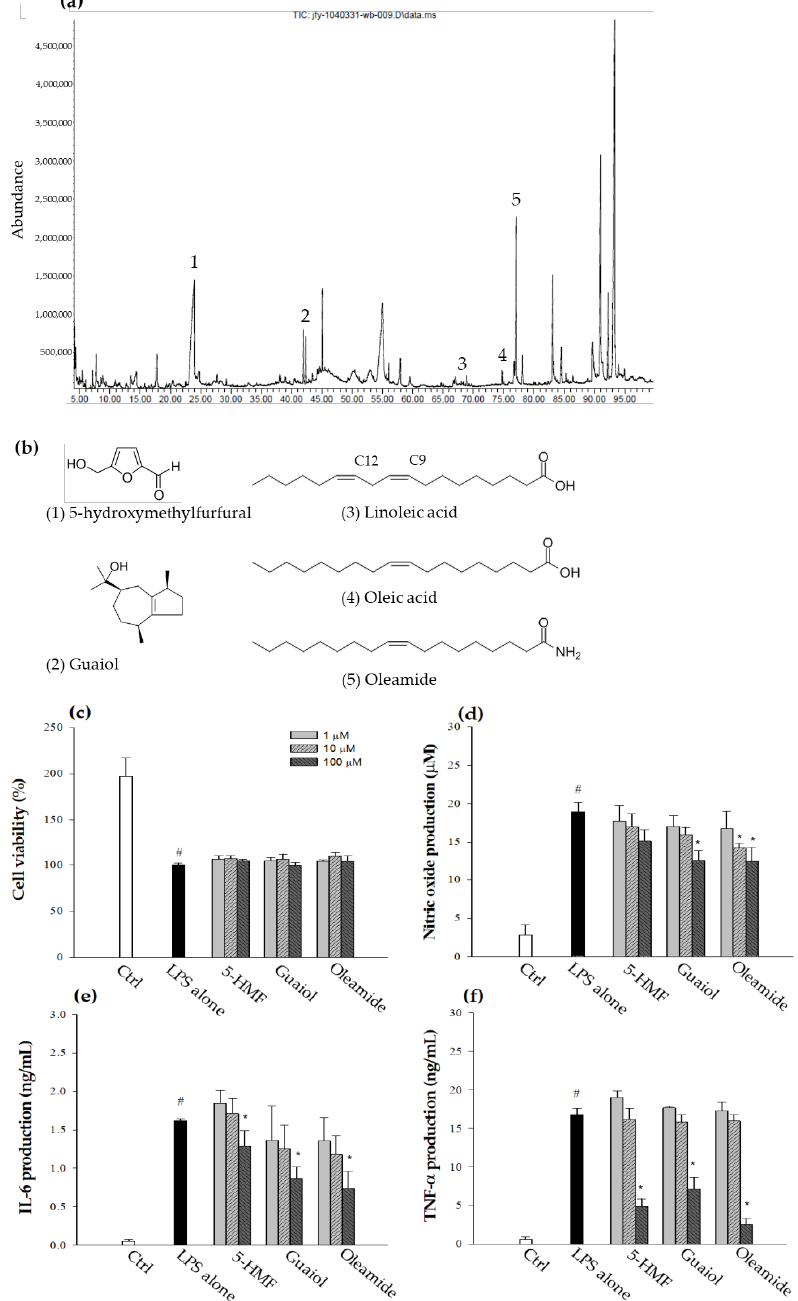
Figure 4. ( a ) GC–MS spectrometry profile of BP-95E-H 2 O-BuOH subfractions of BP. ( b ) Five non- polyphenol components in BP-95E-H 2 O-BuOH subfractions were identified by comparison of their mass spectra with the NIST MS 14.0 database (Gaithersburg) as follows: (1) 5-hydroxymethyl furfural (5-HMF, retention time (RT) = 23.9 min), (2) guaiol (RT = 42.0 min), (3) oleic acid (RT = 67.1 min), (4) linoleic acid (RT = 76.7 min), and (5) oleamide (RT = 77.1 min). ( c ) RAW264.7 cells were treated with 5-HMF, guaiol, and oleamideat for 48 h, and the cell viability was measured with MTT assay. The levels of ( d ) NO, ( e ) IL-6, and ( f ) TNF- α were determined in culture media of LPS -challenged RAW264.7 cells with or without 5-HMF, guaiol, or oleamideat, as described in Section 2. The bars with the symbols # and * represent significant differences ( p < 0.05) from the blank and the control, respectively, according to Student’s t -test.